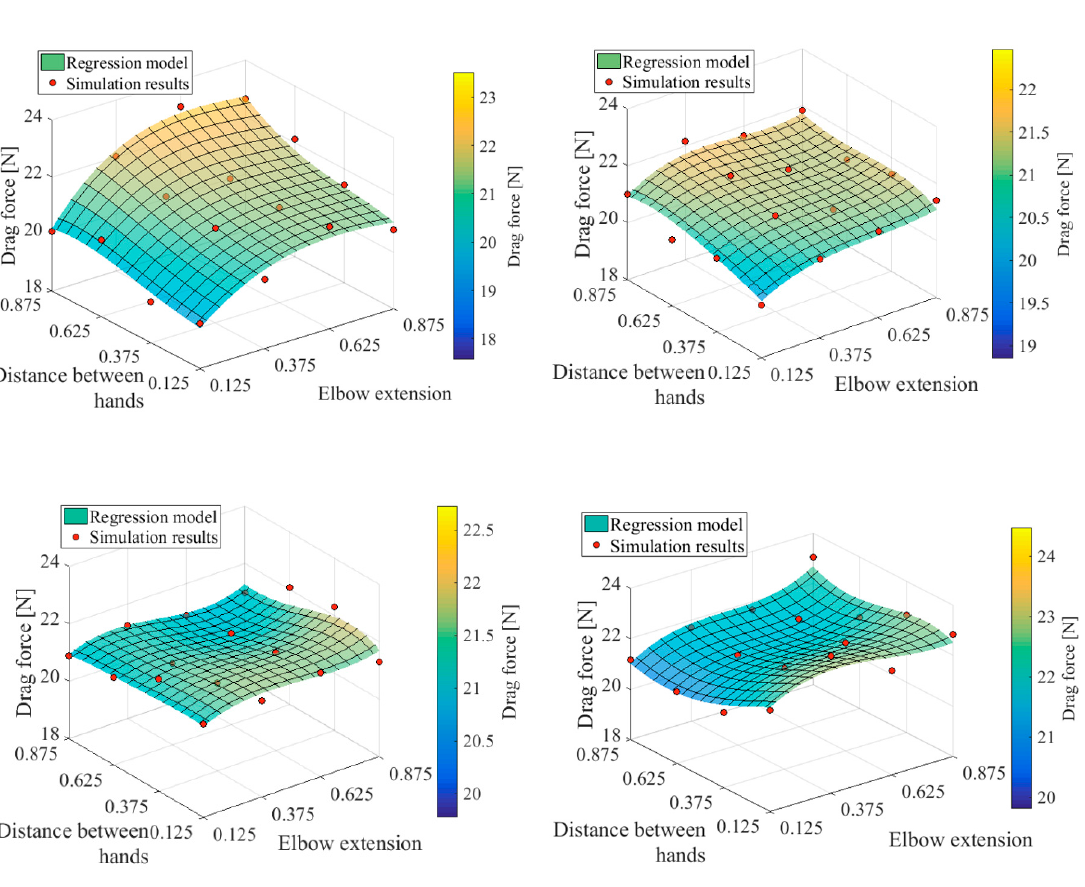
Figure 3. Plots of simulated results and regression model. Top left: Low shoulder abduction, i.e., elbows close together. Top right: Medium shoulder abduction. Bottom left: Medium/high shoulder abduction, i.e., elbows shoulder-width apart. Bottom right: High shoulder abduction, i.e., elbows more than shoulder-width apart.